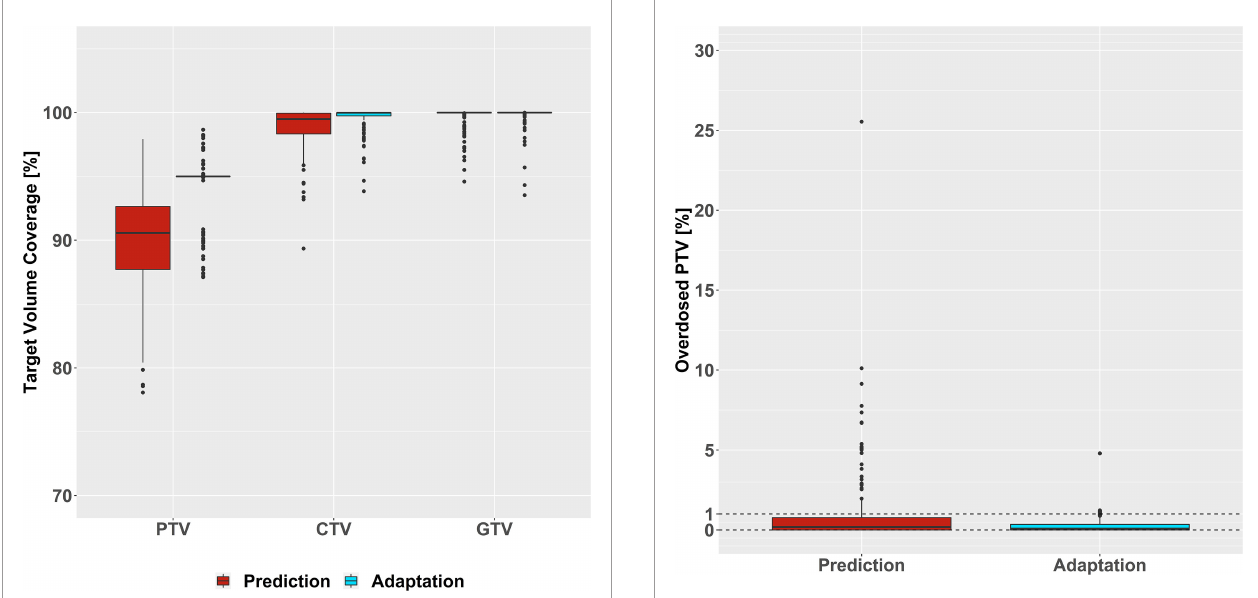
FIGURE 2 | Coverage of Target Volumes. All target volume coverages are given in percent of the target covered by the target dose before (red) and after (blue) plan